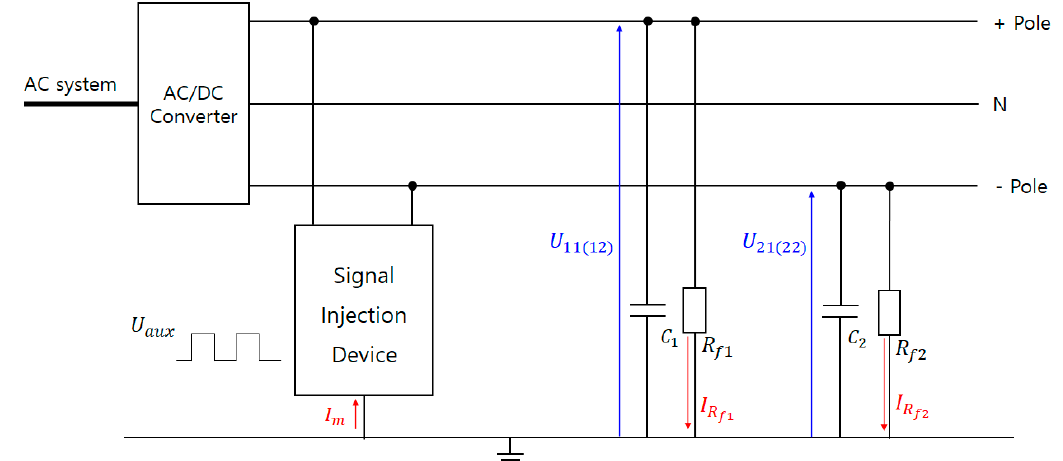
Figure 1. Principle of the pulsating signal generator.